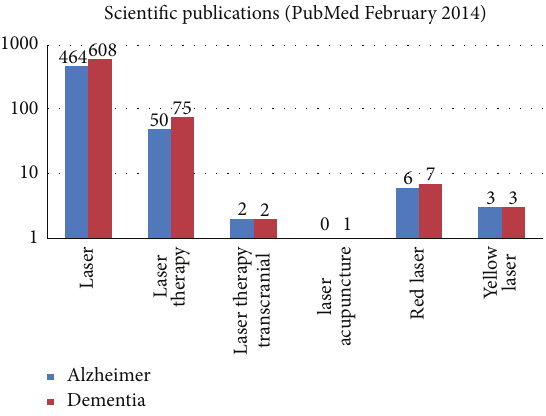
Figure 1: Scientific publications related to the topic in the scientific database PubMed.